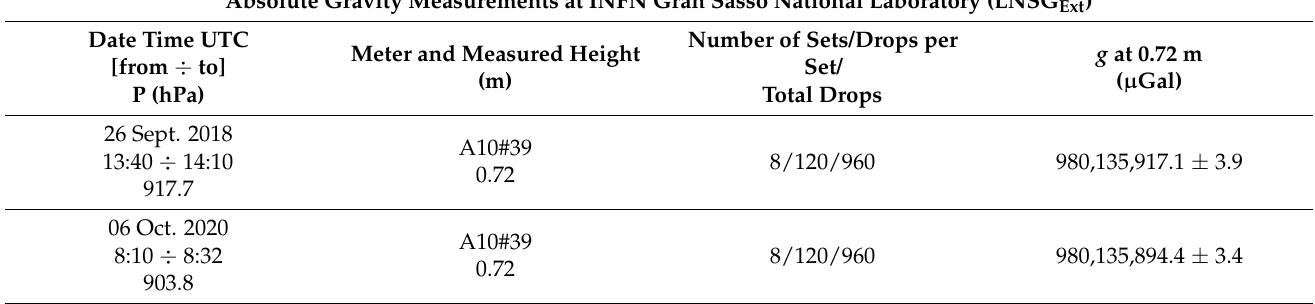
Table 7. Absolute gravity value collected at INFN Gran Sasso station (LNGS EXT ) on 26 September 2018 and 6 October 2020 using the A10#39 absolute gravimeters. The combined uncertainties δ tot associated to the g values are also reported. Absolute Gravity Measurements at INFN Gran Sasso National Laboratory (LNSG Ext